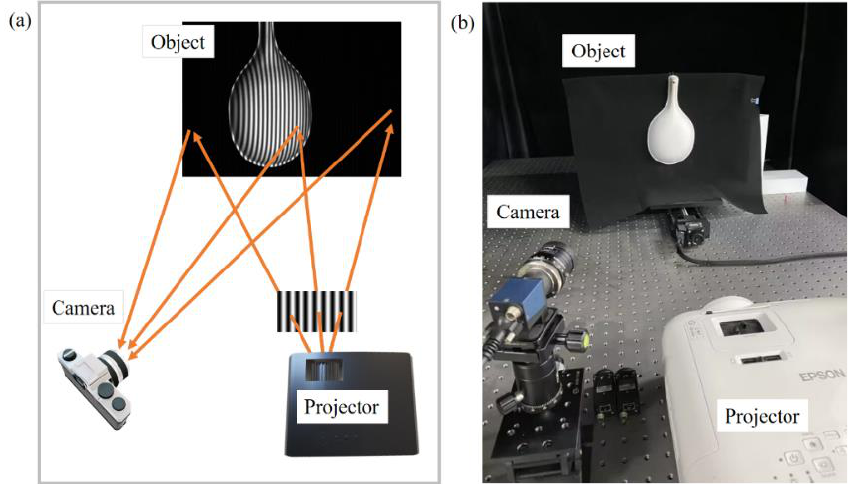
Figure 7. Experimental measurement system. ( a ) Schematic diagram. ( b ) Actual setup diagram.